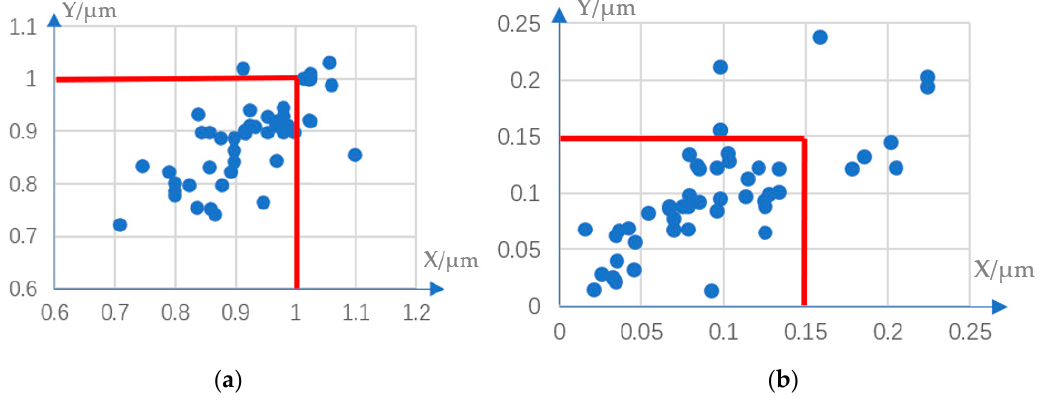
Figure 13. Single shot error before and after compensation. ( a ) before, ( b ) after.